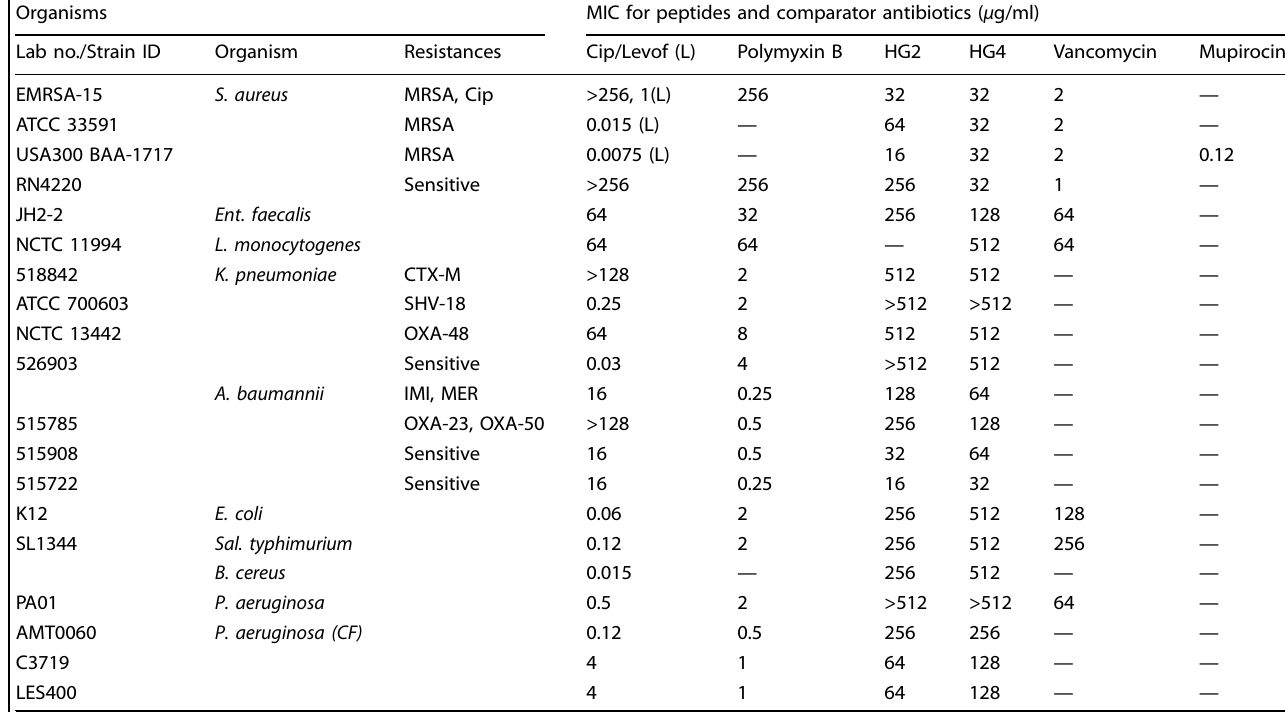
Table 2. MDR bacteria susceptibility to HG2 and HG4 and comparator antibiotics measured by MIC. Organisms MIC for peptides and comparator antibiotics ( µ g/ml) Lab no./Strain ID